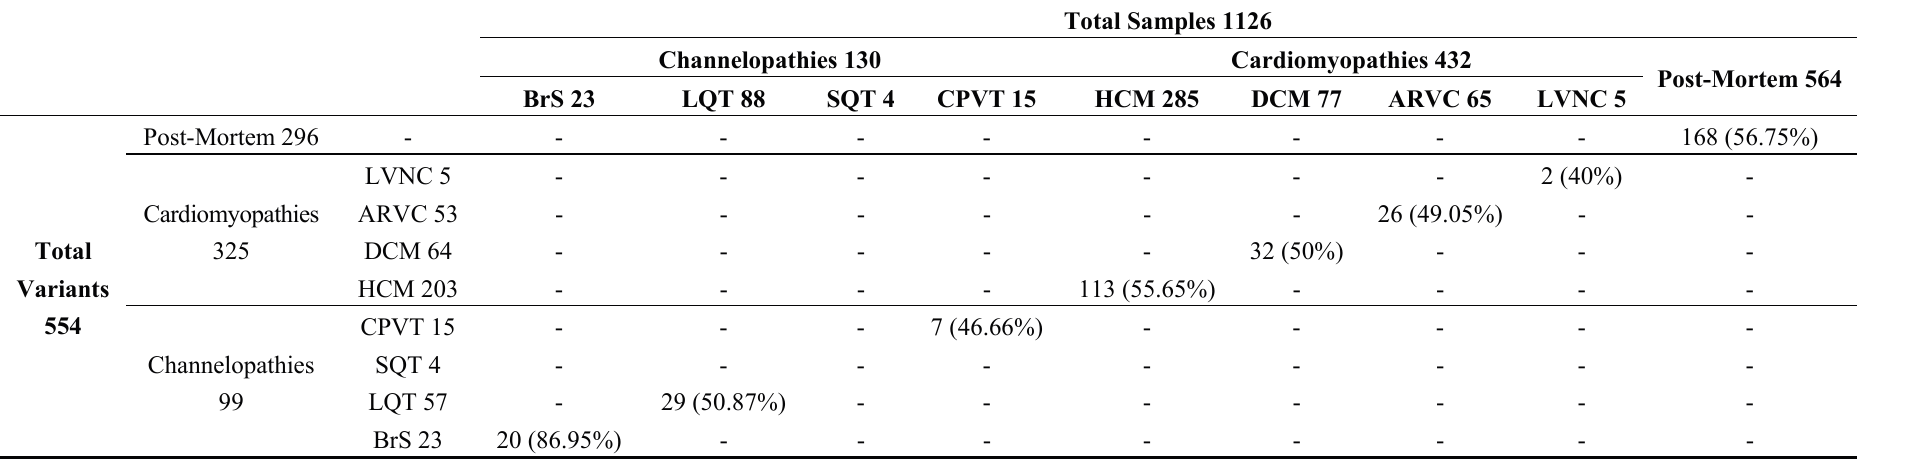
Table 3. Relation of total of samples and total of variants identified only one time in the TTN gene. Inside the table there is the number of variants in TTN only identified one time, and in each